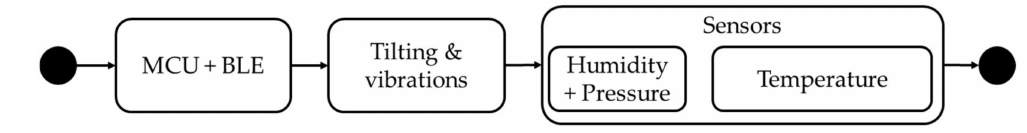
Figure 4. RBD of the sensor node as a series